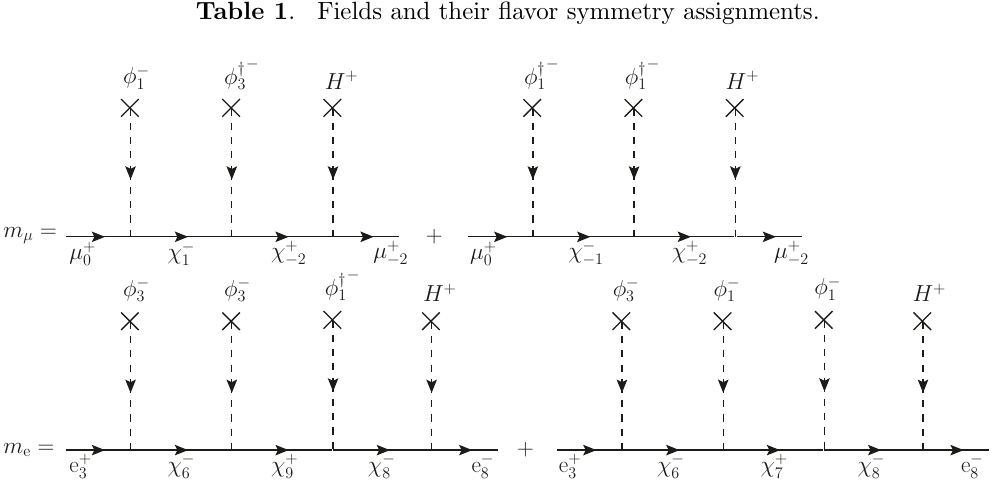
Figure 5 . FN diagrams entering in the generation of the electron and muon masses. The (cid:12)eld subscripts indicate the U(1) f charge while the superscripts specify the Z 2